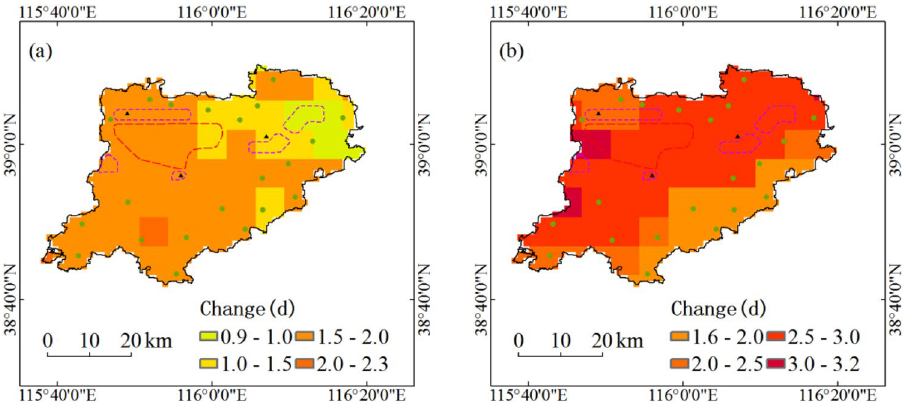
Figure 5. Projected changes of annual longest consecutive high-temperature days with five return periods during the period 1991–2050. Maps show return periods of 10-year, 20-year, 30-year, 50-year and 100-year under RCP4.5 scenario ( a ) and under RCP8.5 scenario ( b ). Maps generated in ArcGIS